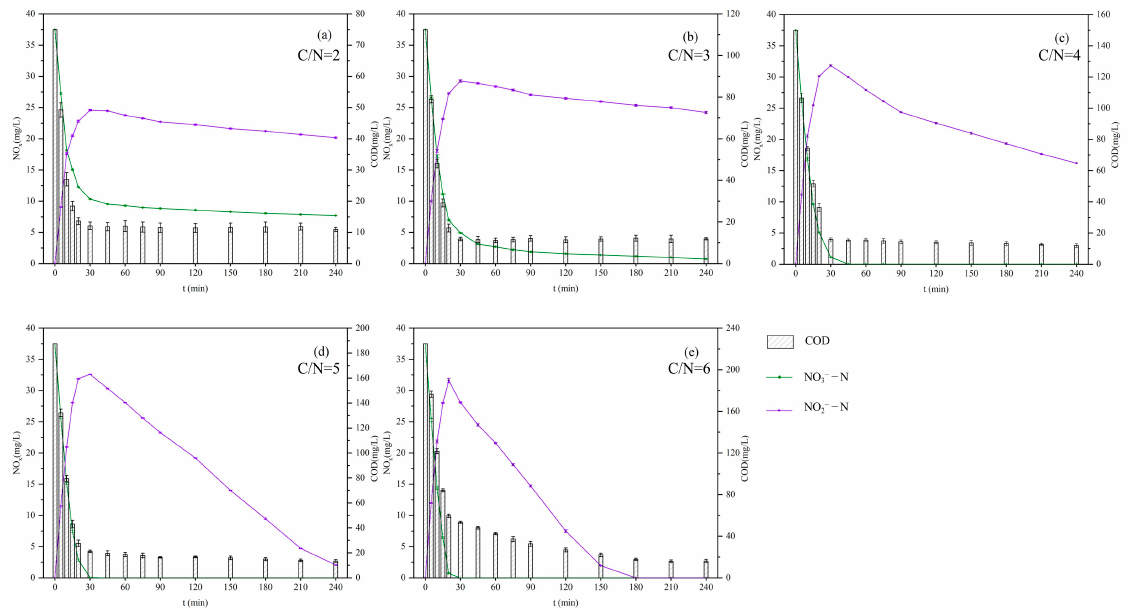
Figure 3. Changes of substrate concentration under different influent C/N: ( a ) 2; ( b ) 3; ( c ) 4; ( d ) 5; ( e ) 6.